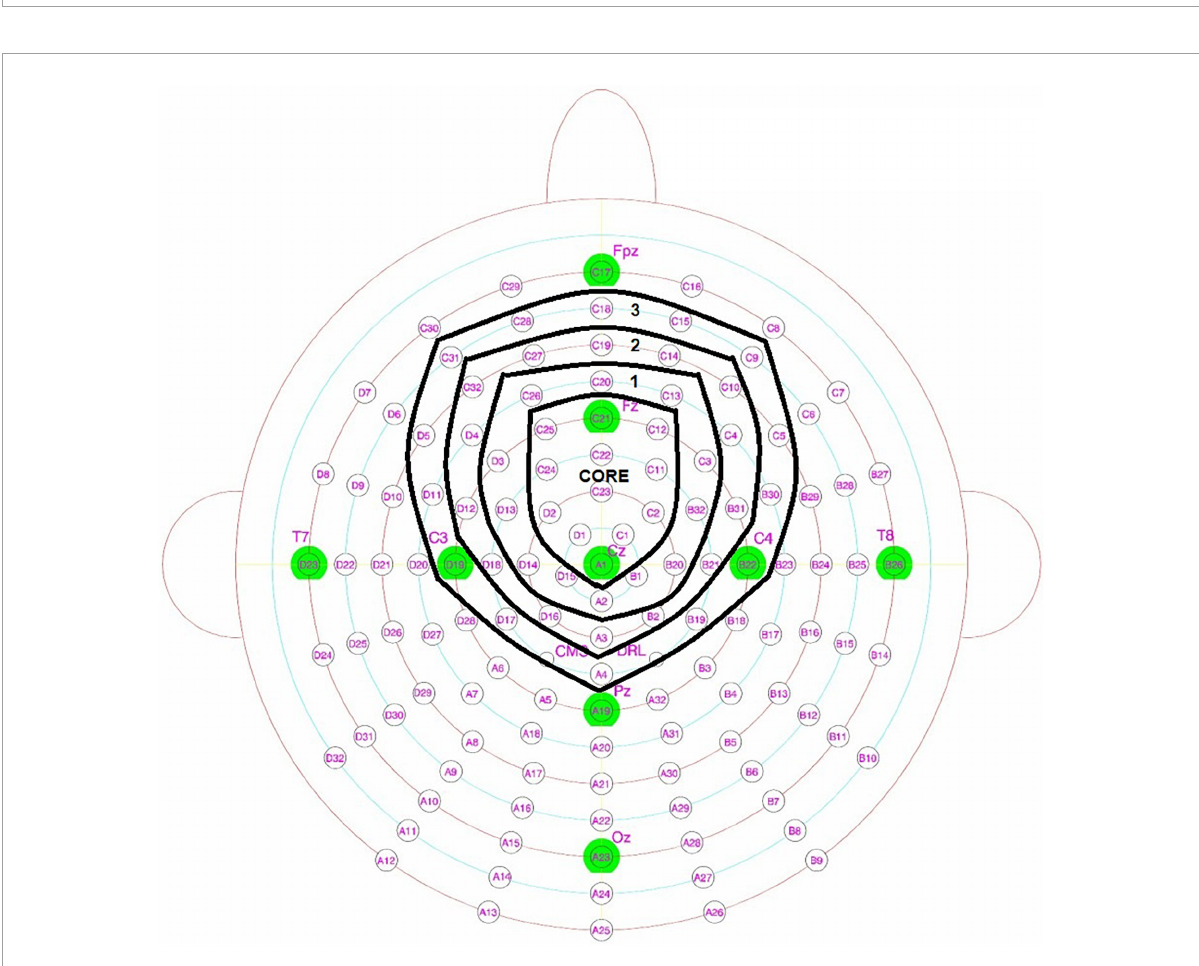
FIGURE2 128 + 2 radial electrode layout illustrating core and outer circle electrode